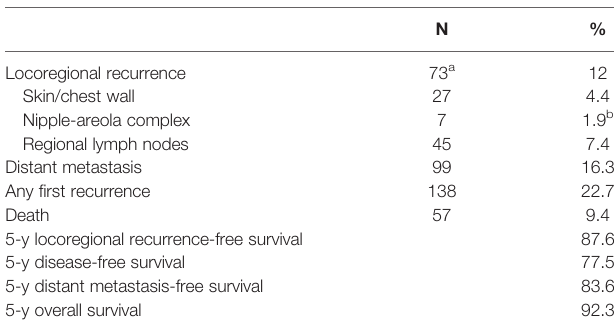
TABLE 2 | Oncologic